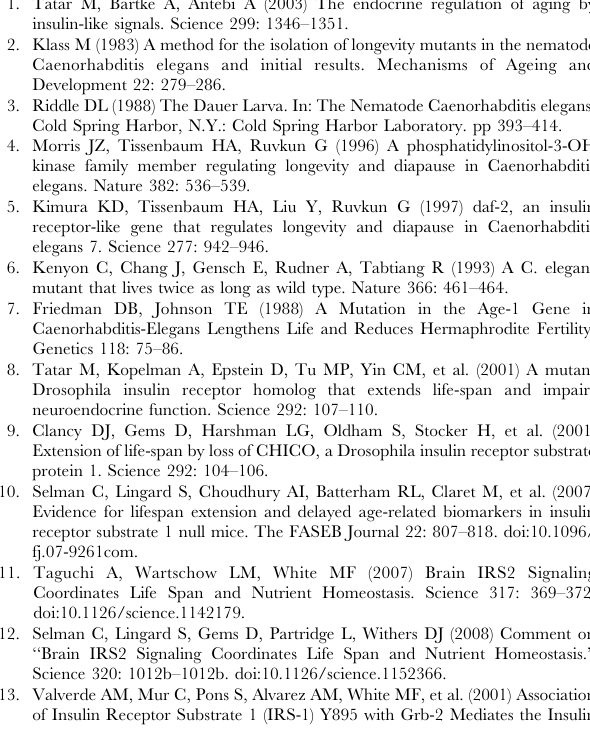
approached significance. The highlighted rows indicate lesions where the uncorrected p-values are less than 0.05. Given that none of these values were significant after adjustment for multiple comparisons, the highlighted values should be interpreted as a possibly meaningful trend rather than a strongly significant difference. Table S6 Males and Females, Disease Burden. Disease burden is defined as the number of distinct lesions observed in an animal (either total lesions or only neoplastic ones) as described in Materials and Methods. In calculating neoplastic burden, lesions were counted separately for each organ in which they were observed with the exception of lymphoma, which was counted only once regardless of how many organs it was found in. The p- values from the genotype and genotype-age effects were adjusted for multiple comparisons using the Holm method [27]. The raw and adjusted p-values for the genotype effect are shown. None of the genotype-age p-values approached